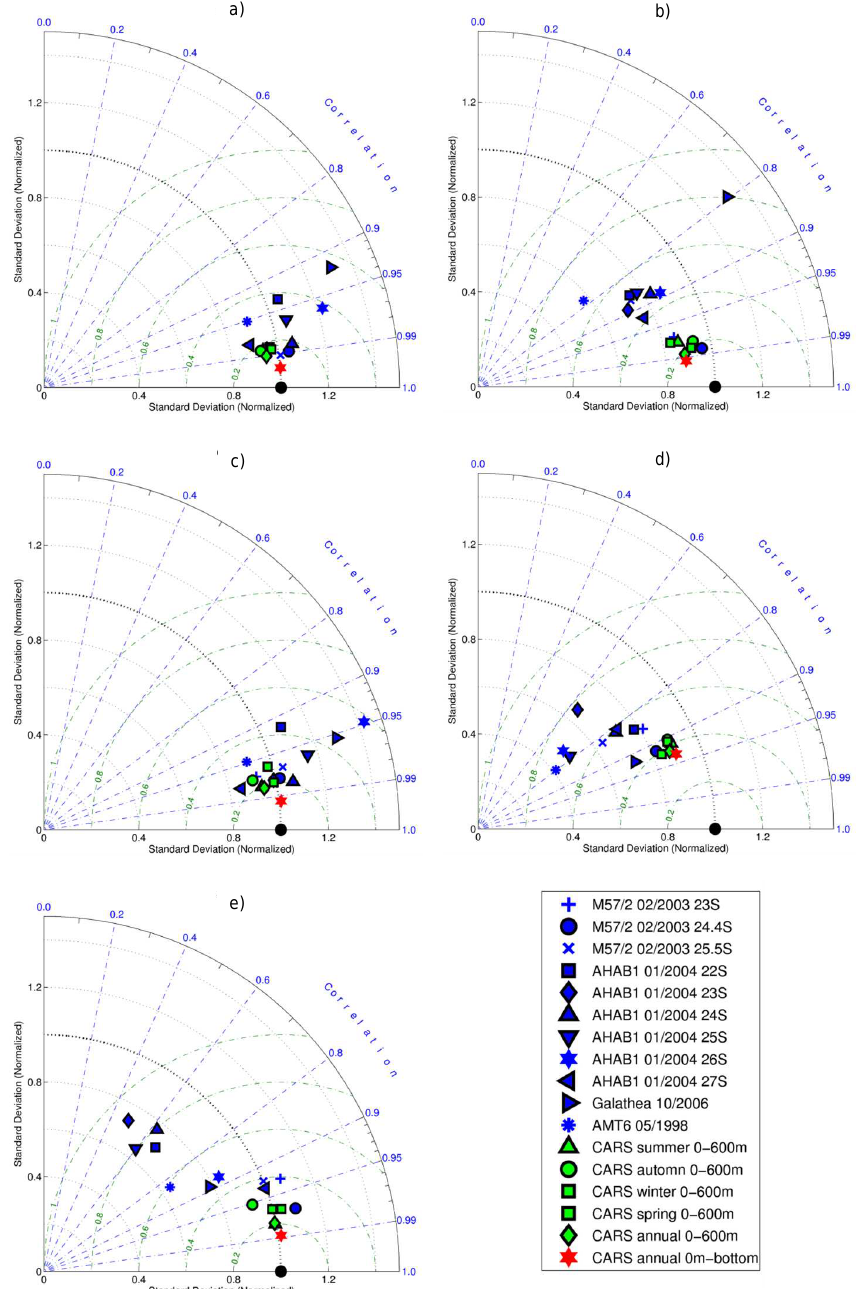
Fig. 4. Taylor diagrams for (a) temperature, (b) salinity, (c) density, (d) oxygen, and (e) nitrate concentrations. The radial distance from the origin is proportional to the standard deviation of a pattern (normalized by the standard deviation of the data: in situ, satellite or climatological data). The green dashed lines measure the distance from the reference point (the data; black filled circle in the diagram) and indicate the RMS error. The correlation between both fields is given by the azimuthal position. The statistics use data from the METEOR expedition 57/2 in February 2003 (transects at 23 ◦ S, 24.4 ◦ S, and 25.5 ◦ S), the AHAB1 expedition in January 2004 (transects at 22 ◦ S, 23 ◦ S, 24 ◦ S, 25 ◦ S, 26 ◦ S, and 27 ◦ S), the Galathea data in October 2006 (surface data, 5 stations, and triaxus data), the AMT 6 cruise in May 1998 (transect at 26.7 ◦ S and 4 stations), and the CARS databases (2006, 2009) (seasonal and annual climatologies). For the comparison with in situ data, simulated fields were monthly averaged (note there are 10 outputs by month) using the last 8yr of simulation (Y12–Y19). For the comparison with CARS database, simulated fields were either seasonally or annually